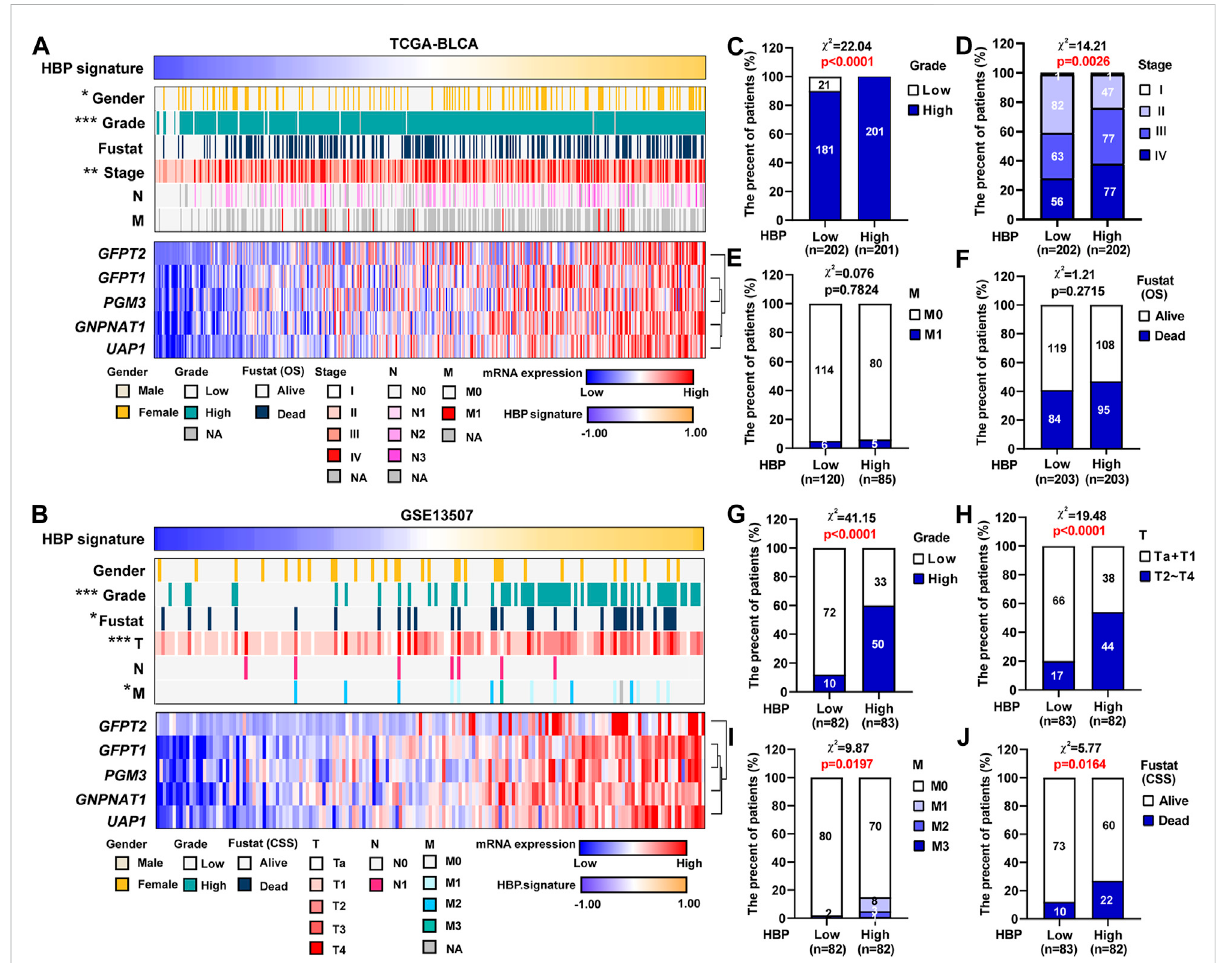
FIGURE 4 The associations between HBP signature level and clinicopathological parameters in UBC patients. (A,B) The heatmaps depicted the associations between HBP signature level and various clinicopathological parameters in TCGA-BLCA (A) and GSE13507 (F) datasets. (C – J) The differences between HBP signature and various clinicopathological parameters, including tumor grade (C,G) , tumor stage (D,H) , metastasis (E,I) and Fustat (OS or CSS) (F,J) in TCGA-BLCA (C – F) and GSE13507 (G – J) datasets. The Chi-square test was used. * p < 0.05, ** p < 0.01, and *** p < 0.001. p values < 0.05 were labelled in